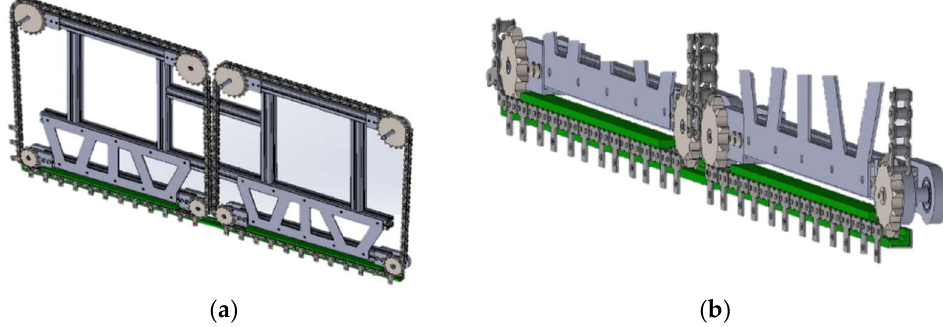
Figure 6. Side module of the roller shutter gripper. ( a ) General view; ( b ) chain guide.